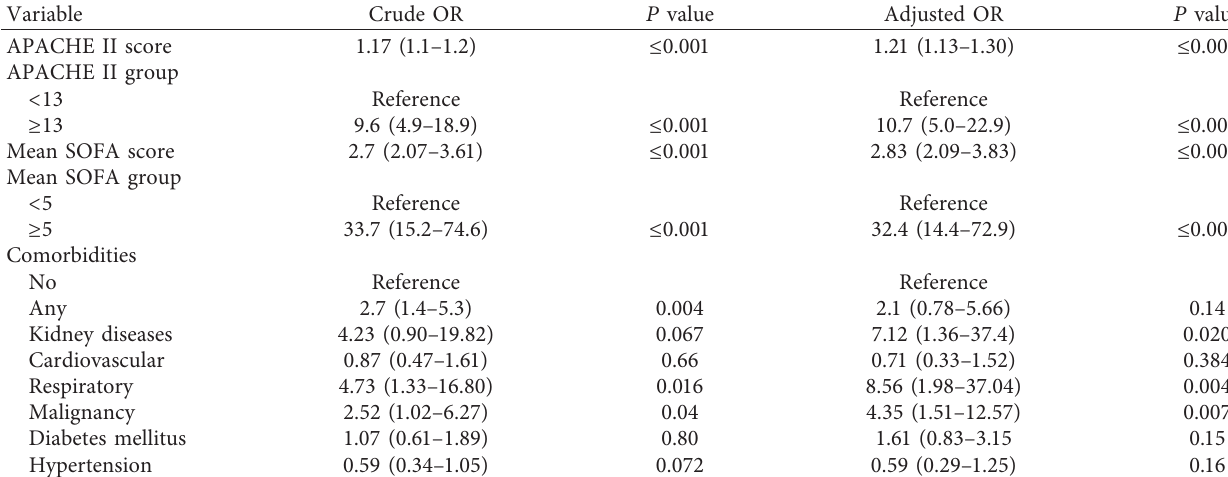
Table 2: Odds ratio and 95% confidence intervals of APACHE II and mean SOFA scores and comorbidities of patients hospitalized for COVID-19 at intensive care unit.